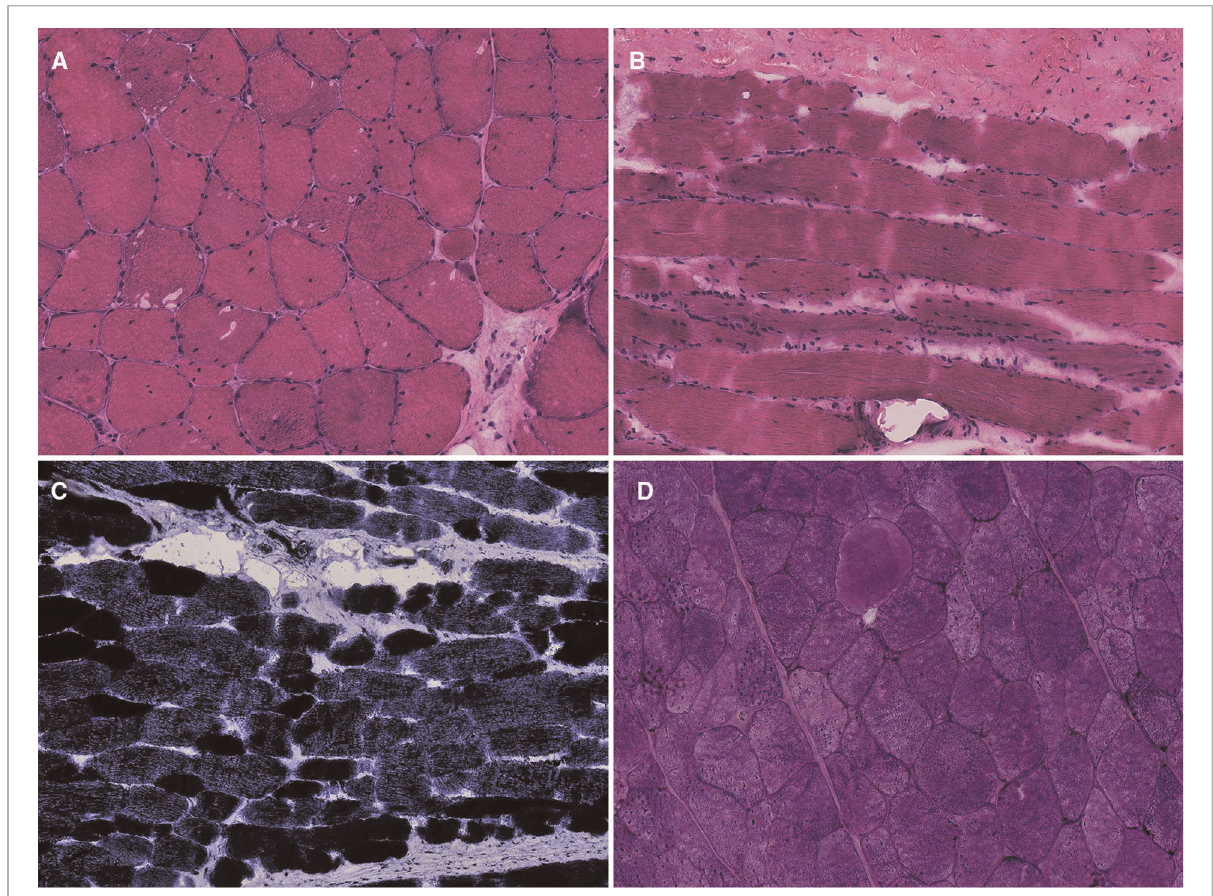
FIGURE 3 Biopsy of paravertebral muscles. ( A ) Hematoxylin-Eosin (HE) staining of the left paravertebral muscle, 20× ; ( B ) HE staining of the right paravertebral muscle, 20×; ( C ) Nicotinamide adenine dinucleotide tetrazolium oxidoreductase (NADH-TR) staining, 10×; ( D ) Periodic acid-schiff (PAS) staining,